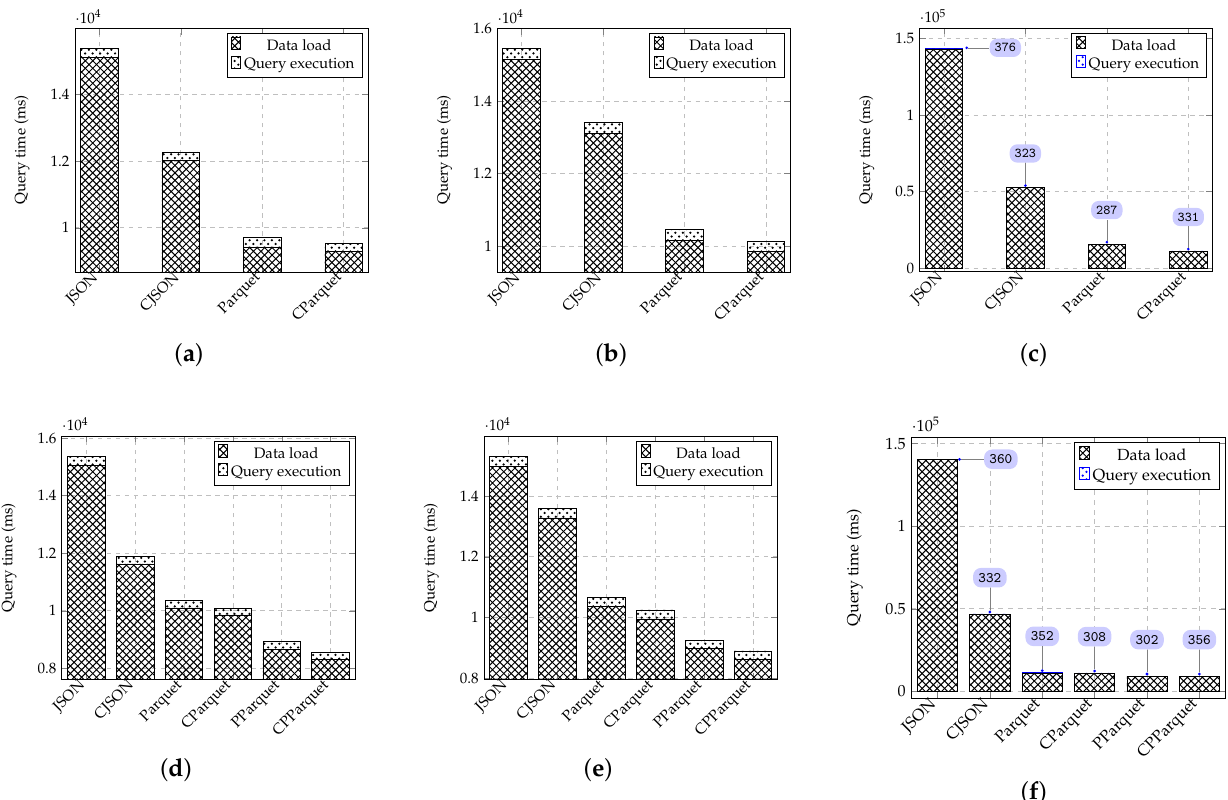
Figure 9. Query time under different scenarios. JSON refers to time spent querying on IoT data stored in JSON format, CJSON represents queries on JSON format-stored IoT data caching in Alluxio, Parquet refers to time spent querying on IoT data stored in Parquet format, PParquet refers to queries on IoT data stored in partitioning Parquet format, CParquet represents time spent on querying on Parquet format-stored IoT data caching in Alluxio, and CPParquet represents queries on Parquet format-stored IoT data caching in Alluxio. ( a ) Q1 ( TCOD ). ( b ) Q3 ( ORMS ). ( c ) Q5 ( RMDAS ). ( d ) Q2 ( TCOD ). ( e ) Q4 ( ORMS ). ( f ) Q6 ( RMDAS